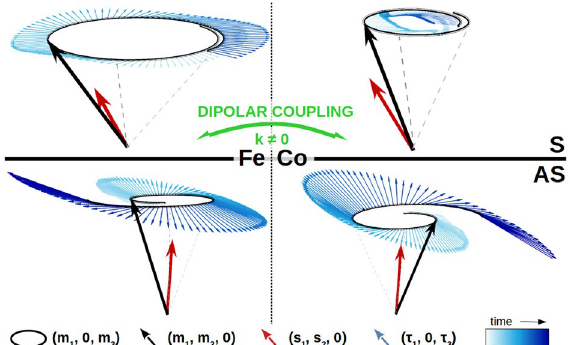
Figure 7. The precession cone of the magnetization in Fe (left) and Co (right) layer for the symmteric mode S (up) and antisymmetric mode AS (bottom), the spin accumulation and generated spin-transfer torques. The precession trajectory and spin-transfer torques are taken from numerical simulations. The spin transfer torques are averaged through each layer